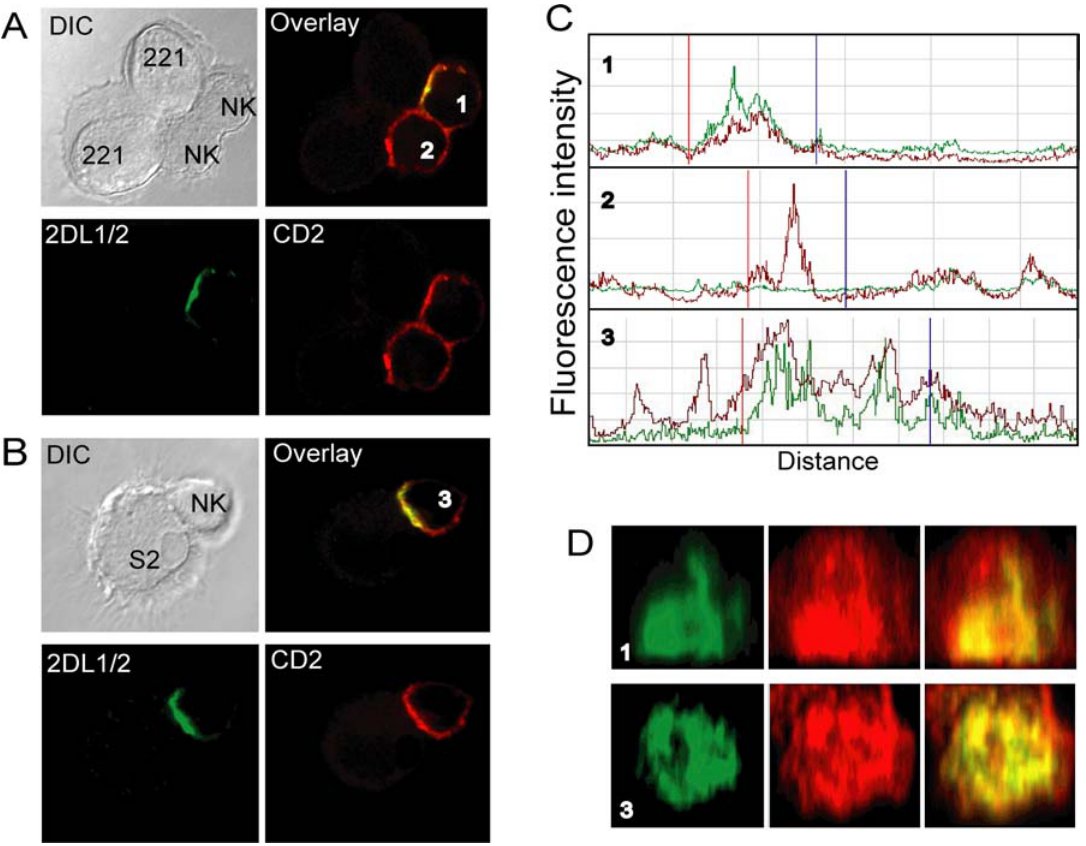
Figure 2. CD2 accumulates at both activating and inhibitory synapses. IL-2 activated polyclonal human NK cells were mixed with target cells at 37 u C for 10 minutes, fixed, permeabilized, and stained with the cyt42/43 antiserum and a mAb to CD2 followed by the relevant secondary antibodies. Confocal microscope z -series were obtained. (A) Mixed with .221-Cw15 as indicated. A single confocal section is shown. The cell labeled # 1, which displays KIR expression and clustering, represents an inhibitory synapse while cell # 2, which lacks KIR2DL1 expression, displays an activating synapse. (B) Mixed with S2–LFA-3/Cw4 target cells, as indicated. A single confocal section is shown. (C) The fluorescence intensity was scanned around the perimeter of conjugated NK cells. Profiles labeled 1, 2, and 3 are from the corresponding cells in Figures 2A and 2B. The green and red lines represent the cyt42/43 and anti–CD2 fluorescence, respectively. Vertical red and blue lines mark the boundaries of cell contact as determined in DIC images. (D) Confocal z -stacks were used to create an en face view of the zone of cell contact in 2 inhibitory